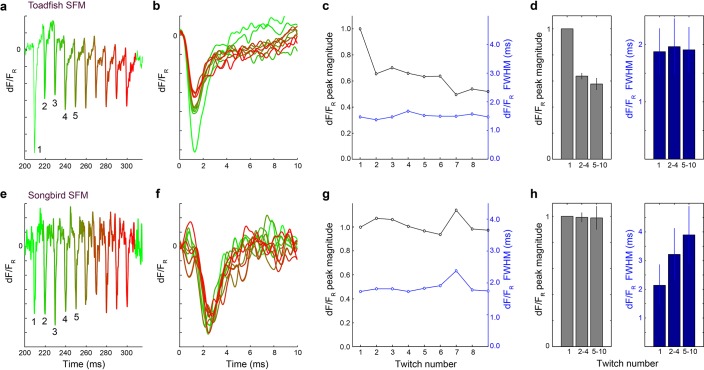
Calcium transient speed is stable over multiple stimulations.(a) Representative traces of changes in fluorescence (dF) scaled to resting fluorescence (FR) during multiple stimulations in toadfish SFMs. The dF/FR signal inversely relates to the myoplasmic calcium concentration ([Ca2+]i). The first transient clearly shows an increased peak magnitude compared to the consecutive transients. Color coding from green (twitch 1) to red (twitch 10). (b) dF/FR transients overlaid for the 10 twitches and (c) corresponding dF/FR peak magnitude and FWHM as a function of twitch number. (d) In toadfish SFMs, dF/FR peak magnitude is higher for the first twitch compared to the consecutive ones confirming earlier observations (Harwood et al., 2011), but dF/FR FWHM does not change as a function of twitch number. (e–g) Results for zebra finch SFM. (h) Both dF/FR peak magnitude and FWHM do not significantly change as a function of twitch number (KW, p>0.05). The trend to longer duration FWHM with twitch number may be explained by measurement inaccuracy due to low signal to noise ratio.